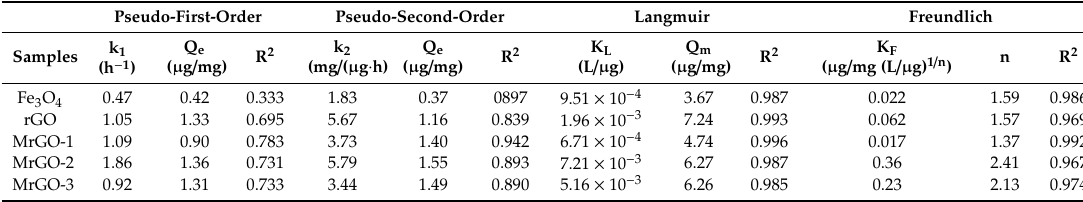
Table 2. Relevant parameters of the adsorption